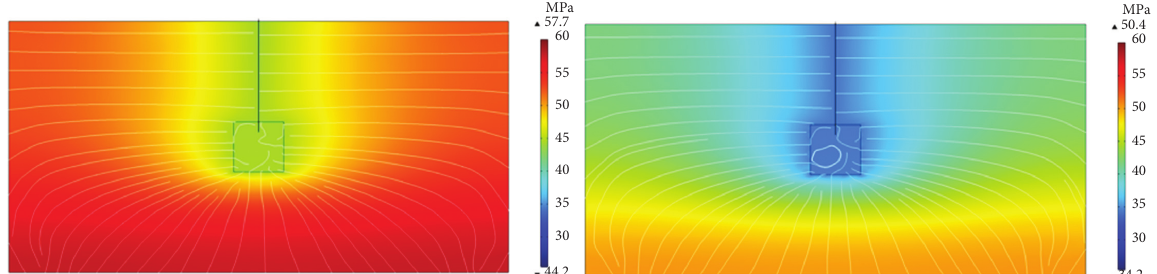
Figure 3: Comparison of two-dimensional pressure field distribution at the initial stage and later stage.